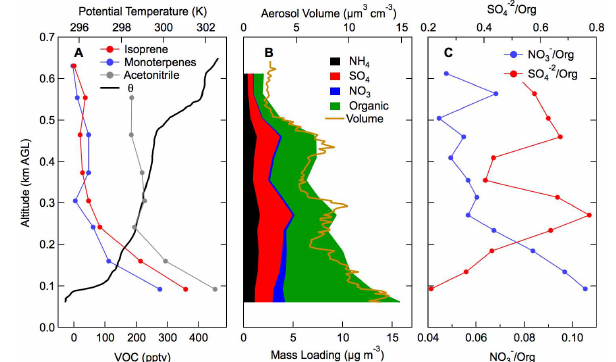
Fig. 13. Vertical profile from the descent to Lone Star airfield on 12 October. (A) Mixing ratio of isoprene, monoterpenes and acetoni- trile (bottom axis) and potential temperature profile (top axis). (B) Mass loading of ammonium, sulfate, nitrate and organic from the AMS (bottom axis), and total aerosol volume (top axis). (C) Ratio of nitrate and sulfate to organic mass (bottom and top axes, respec-